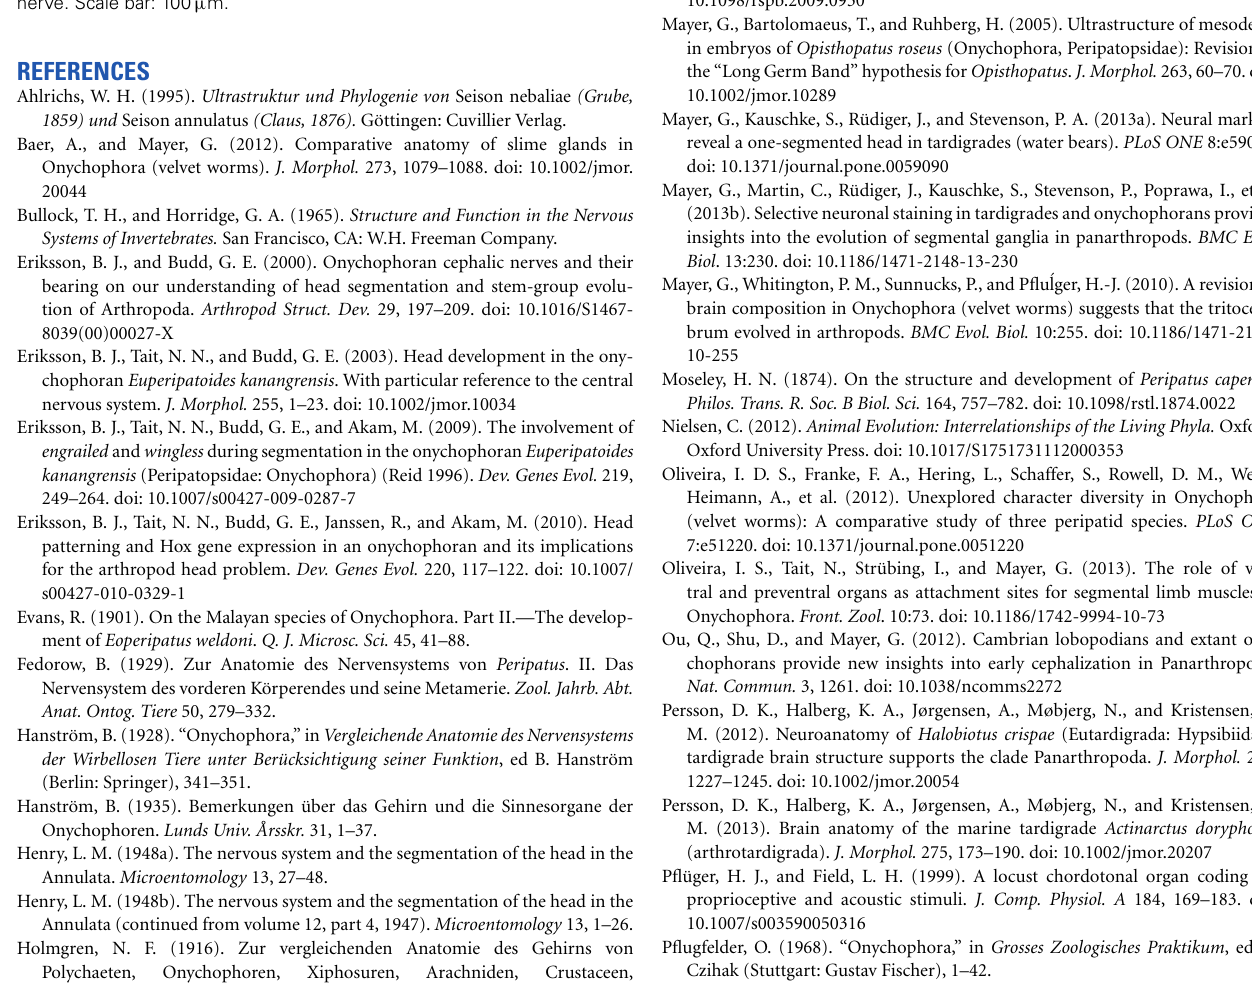
Supplementary Figure S3 | Localization of somata of peripheral neurons associated with lip papillae in Euperipatoides rowelli . Anterograde fills of the third lip papillae nerve (L3) with dextran coupled to the fluorescent marker tetramethylrhodamine. Projections of confocal micrographs. Lip papillae surrounding the mouth opening are numbered. Overview of an external perspective (subset on the left) and an internal perspective (subset on the right) showing the position of neuronal somata within the lip papillae associated with the third lip papillae nerve (L3). Note that L3 receives fibers from neuronal cell bodies located in the second to eighth lip papillae. Abbreviations: dm, definitive mouth opening; L3, lip papillae nerve. Scale bar: 100 μ